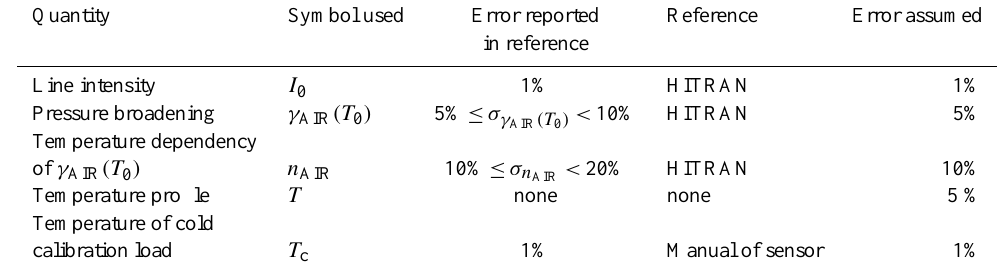
Table 3. Individual error figures contributing to the error budget for O 3 retrievals from the 142.176GHz line as plotted in Fig. 7. Quantity Symbol used Error reported Reference